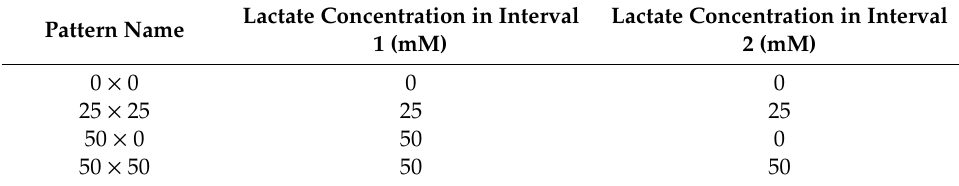
Table 1. Intermittent patterns of lactate exposure.